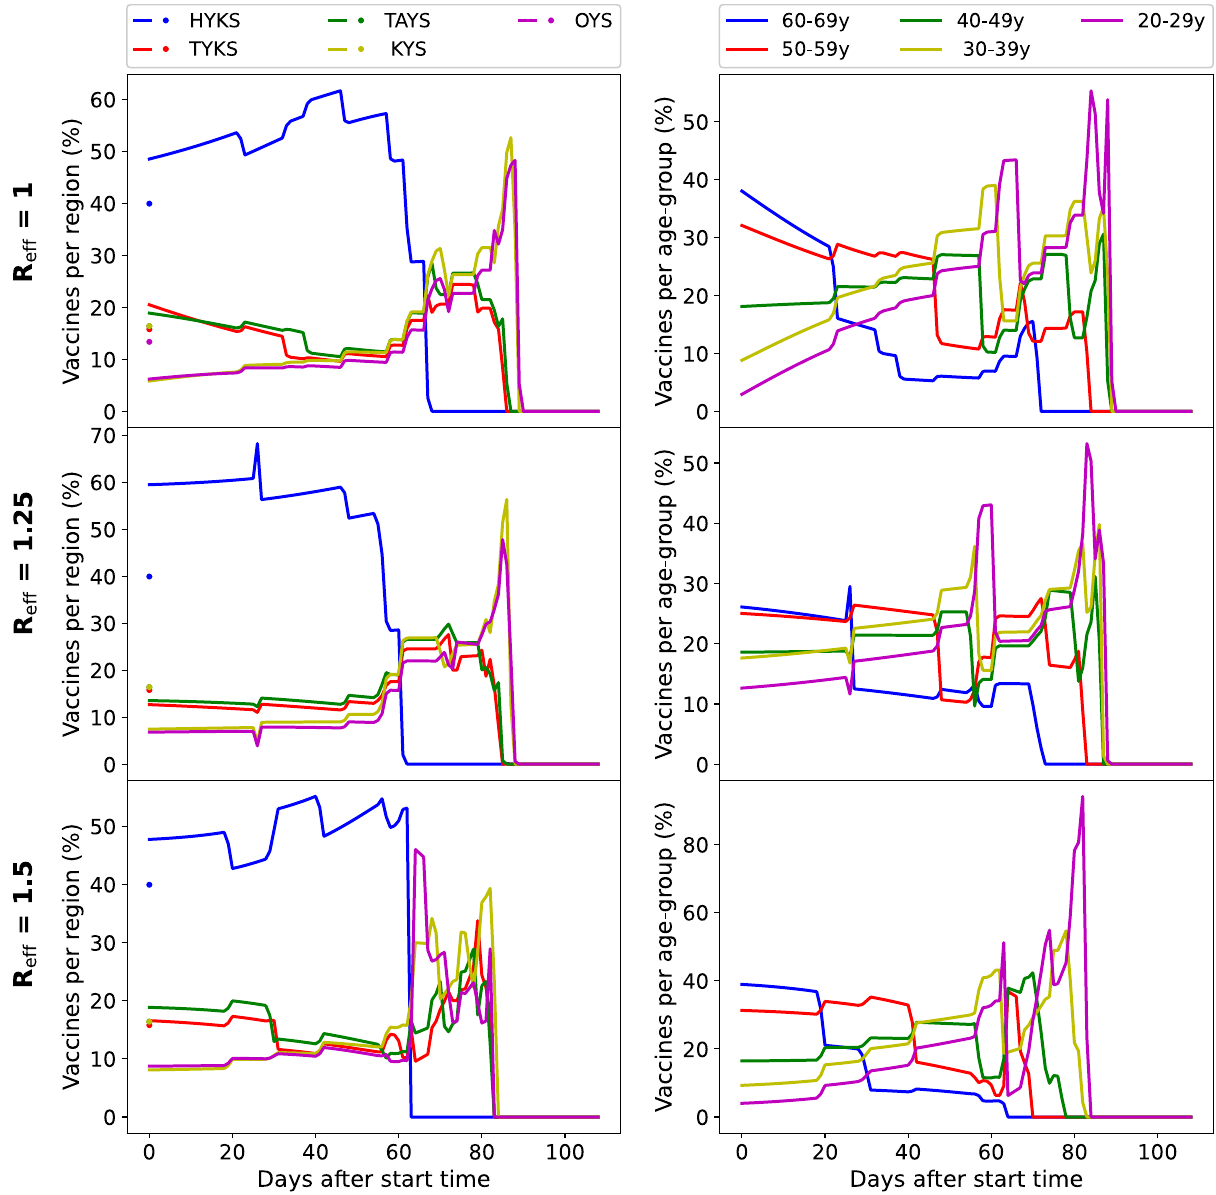
Fig 4. Percentage of vaccine doses allocated by the optimized strategy to regions (left) and age groups (right) in three scenarios ( R eff = 1, 1.25, 1.5). On the left, dots represent the percentage of vaccines which each region would receive with Pop